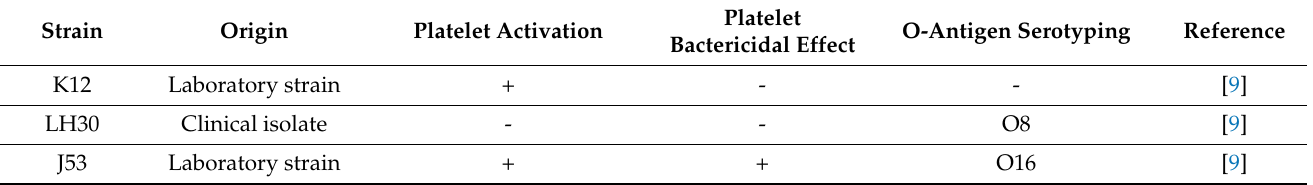
Table 1. Origins and profiles of tested